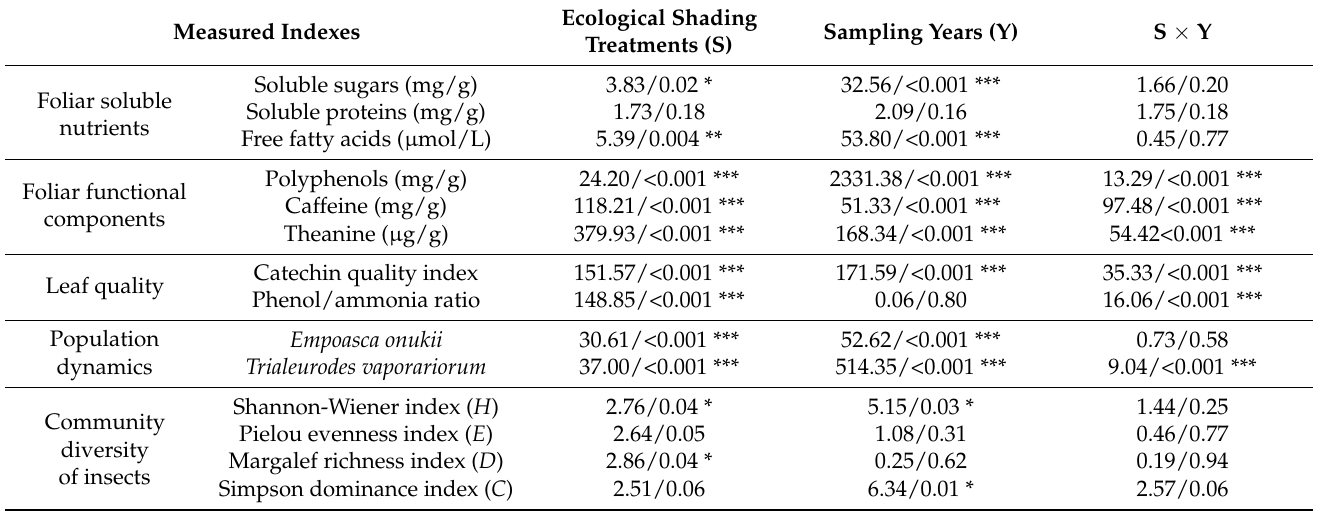
Table 1. Two-way repeated-measures ANOVAs of ecological shading treatments (including SS, SSCK, ES, WS, EWCK) (S), sampling year (Y) and their interaction (with sampling time as repeated measures) on the foliar contents of soluble nutrients, the functional components and leaf quality indexes of tea plants, and the population dynamics of two key insect species of Empoasca onukii and Trialeurodes vaporariorum , as well as the community indexes of the collected insects in the tea plantation (values were F / p ) (* p < 0.05; ** p < 0.01; *** p <